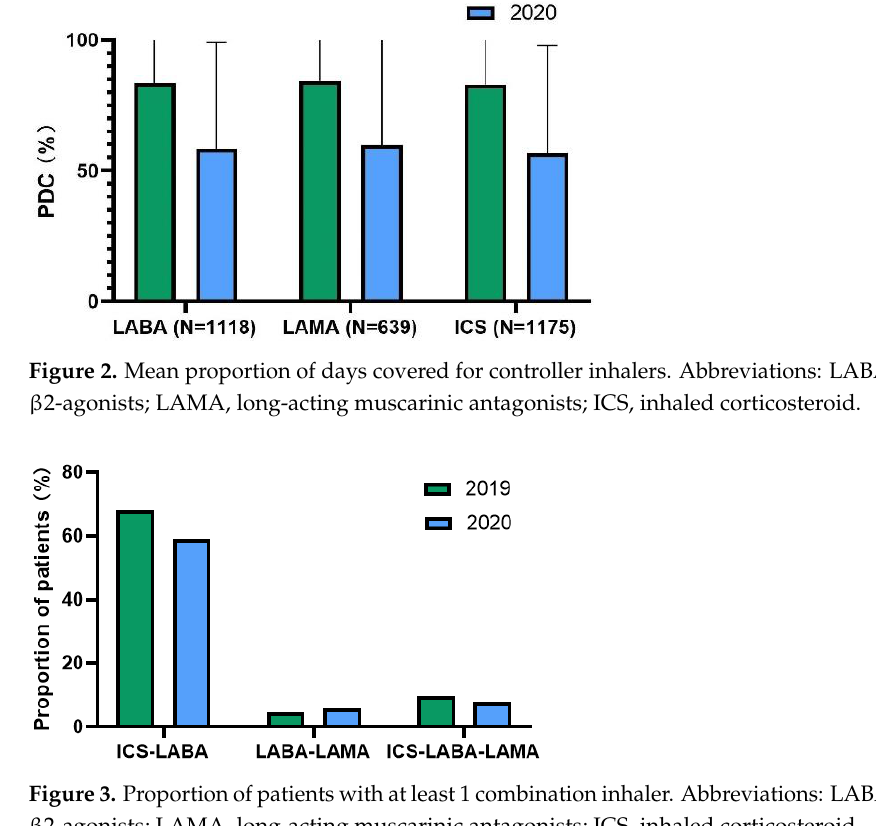
Figure 3. Proportion of patients with at least 1 combination inhaler. Abbreviations: LABA, long-acting β 2-agonists; LAMA, long-acting muscarinic antagonists; ICS, inhaled corticosteroid. The percentage of patients adhering to their treatment dropped from 74.4% in 2019 to 58.1% in 2020, with p < 0.001. The percentage of patients who received ICS and LABA decreased from 68% to 59%. However, the number of patients who used the combination of ICS, LABA, and LAMA increased from 71 to 91. The number of patients receiving oral corticosteroids decreased from 493 (32.2%) in 2019 to 414 (25.7%) in 2020. In the regression model of 2019, the full model containing all predictors was statistically significant, X 2 (27, N = 1533) =240.19, p < 0.001. The model as a whole explained